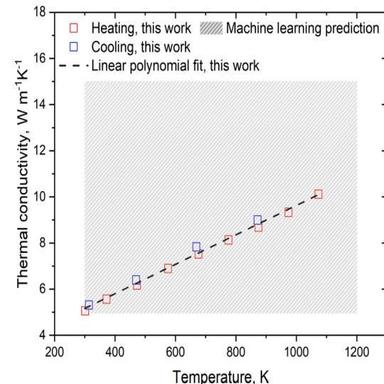
Measured thermal conductivity of annealed USiNi sample and predictions by the machine learning model.